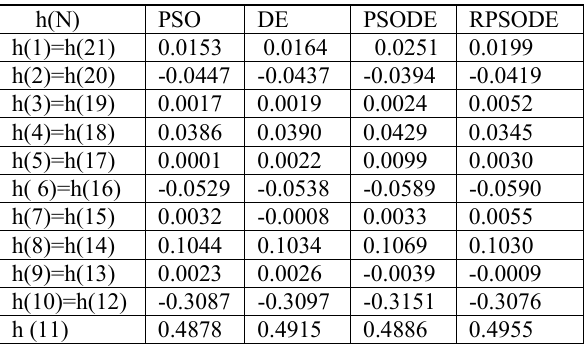
Table2. Optimized coefficients of FIR LP filter of order 20 using PSO, DE, PSODE and RPSODE